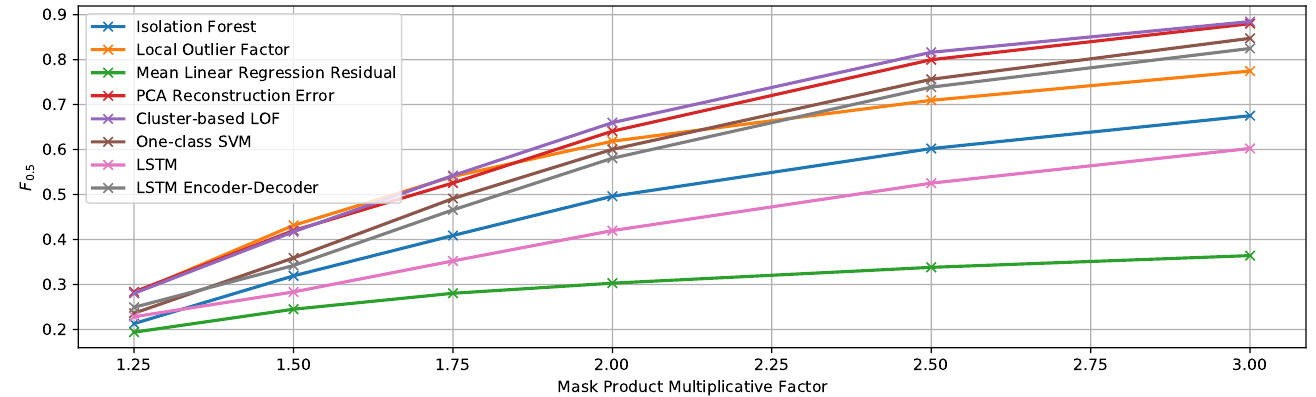
Figure 11. F 0.5 score of the multivariate detection methods using the true contamination value for experiment EF1.